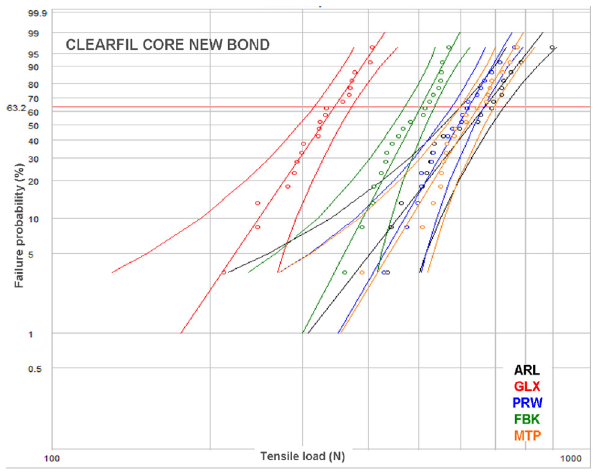
Figure 6. Weibull plot for the posts restored with CNB. Table 3. Results of the Weibull analysis for reliability ( β ), characteristic life ( σο ) and the correlation coefficient of the measurements (r 2 ). Same lower-case letters show insignificant differences for β and